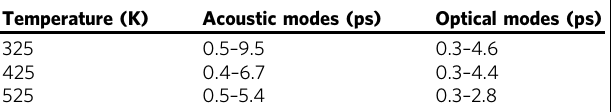
Table 1 Range for the lifetimes of acoustic and optical phonons in CsPbBr 3 , calculated for different temperatures Temperature